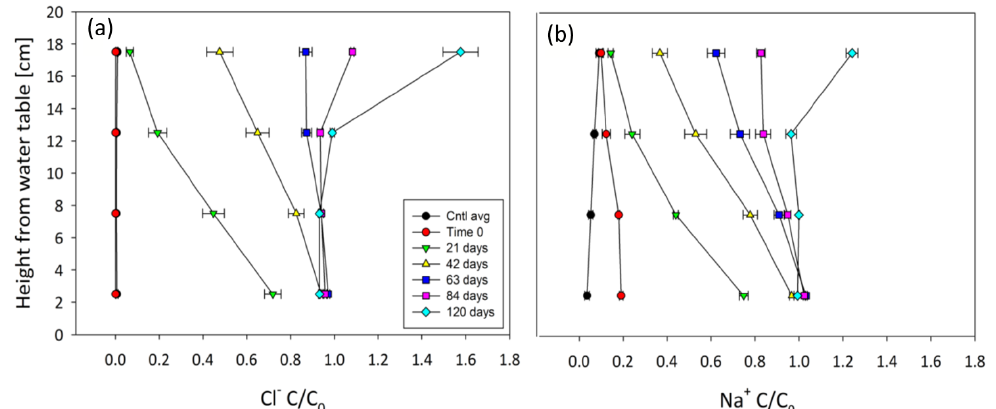
Figure 5. Breakthrough curves of solutes in the unsaturated columns profile (a) of Cl − and (b) of Na + . Values presented are averages and whiskers are standard errors. “Cntl avg” represents the average of control measurements; for this aim, all measurements in a specific height were averaged with each point representing 18 measurements. For the treatment, each point is an average of three measurements. Each treatment curve represents a different sampling time from start of experiment. The water table location is at 0cm.